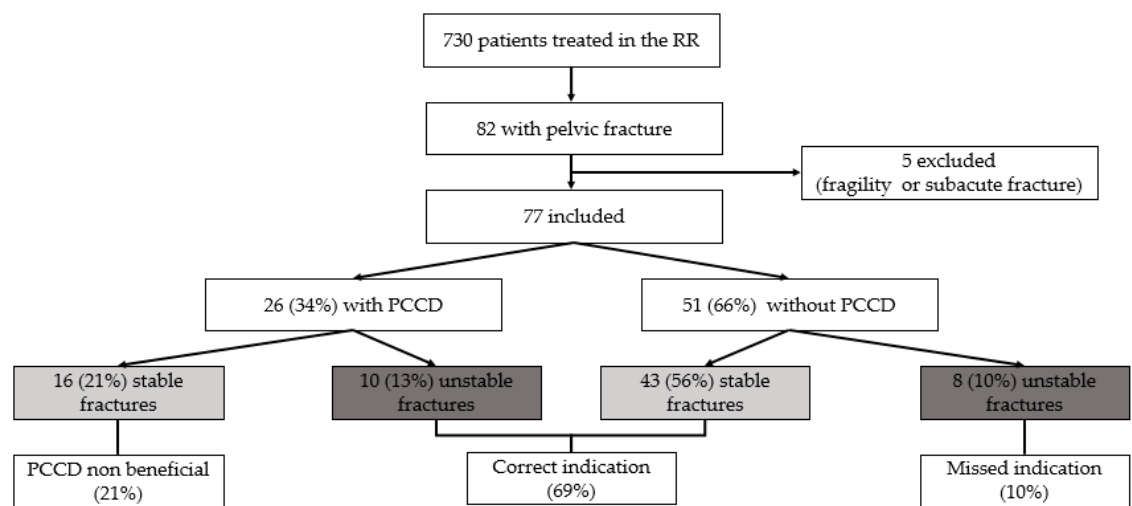
Table 1. Demographic data.